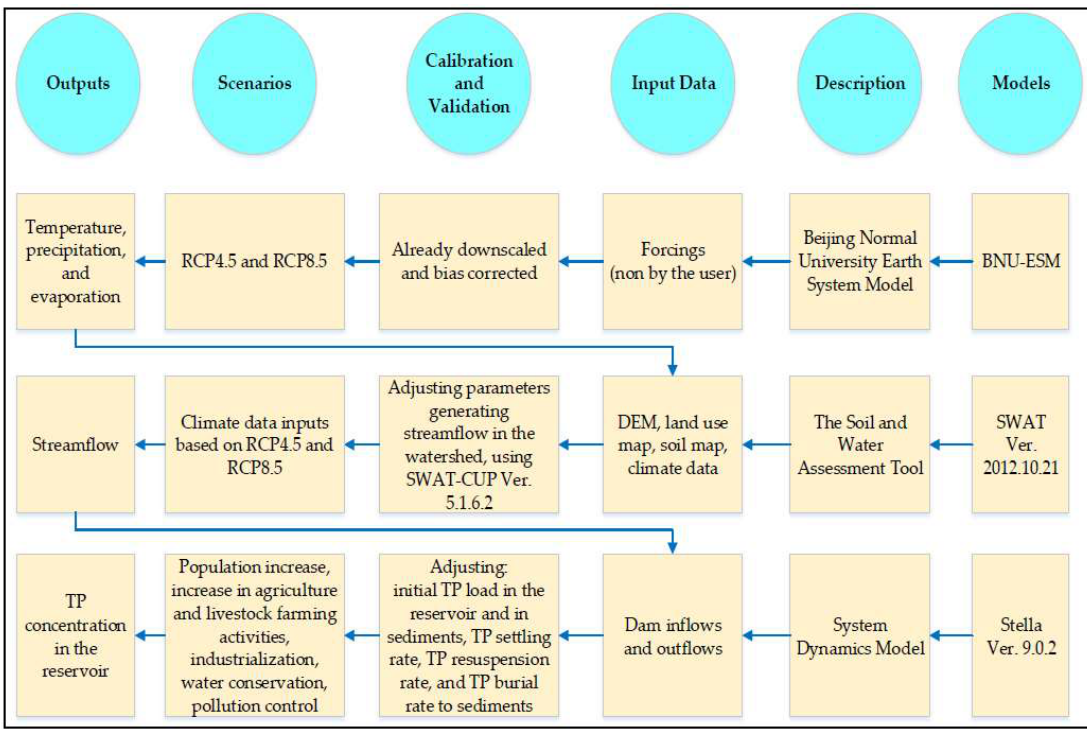
Figure 1. The framework of this study.